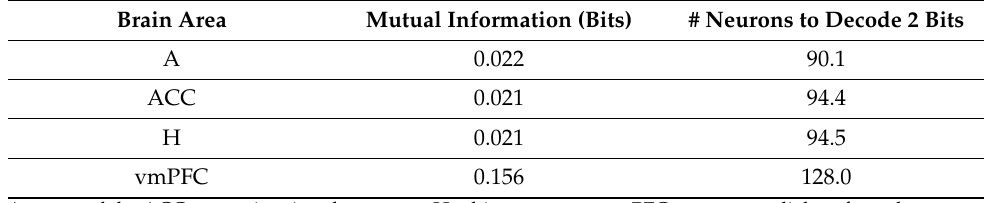
Table 3. Average information for decoding race in single-neuron firing in each brain area. Brain